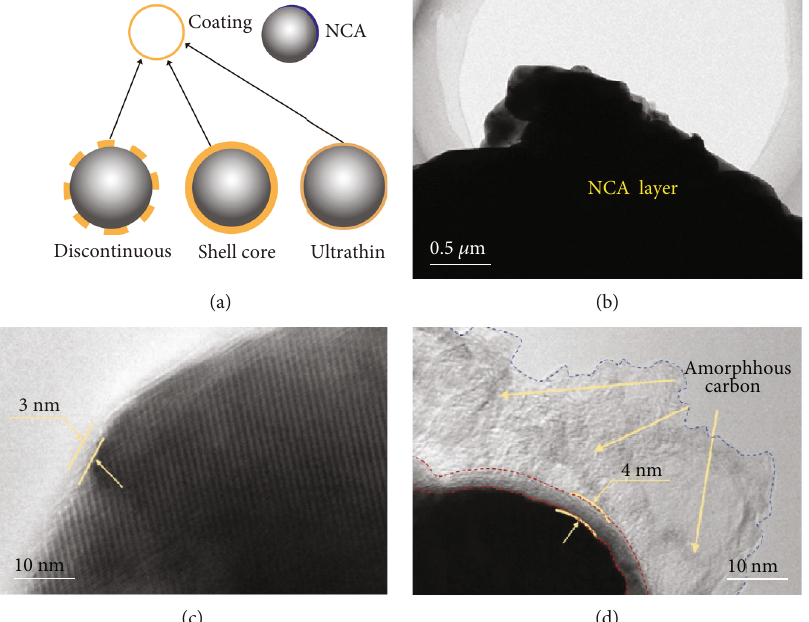
Figure 2: Types of electrode material surface coating (a). TEM images of NCA coated with di ff erent carbon sources: (b) bare; (c) glucose 1% NCA/C; (d) sucrose 1% NCA/C